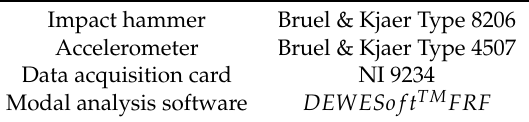
Table 2. Modal analysis setup details.